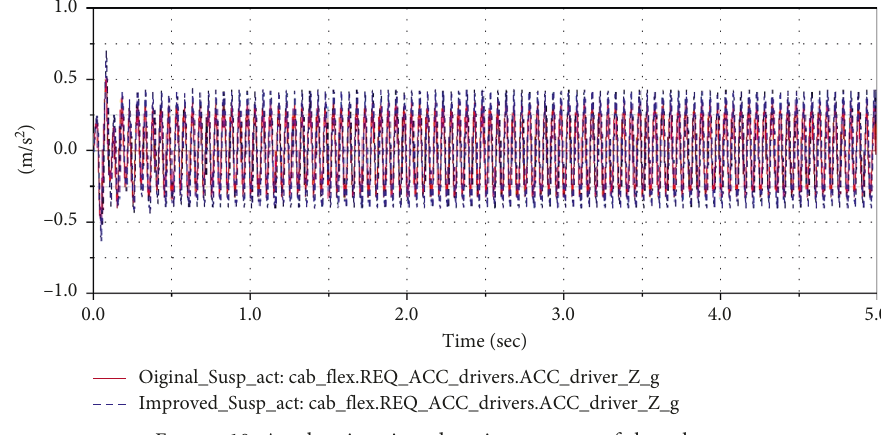
Figure 10: Acceleration time-domain spectrum of the cab